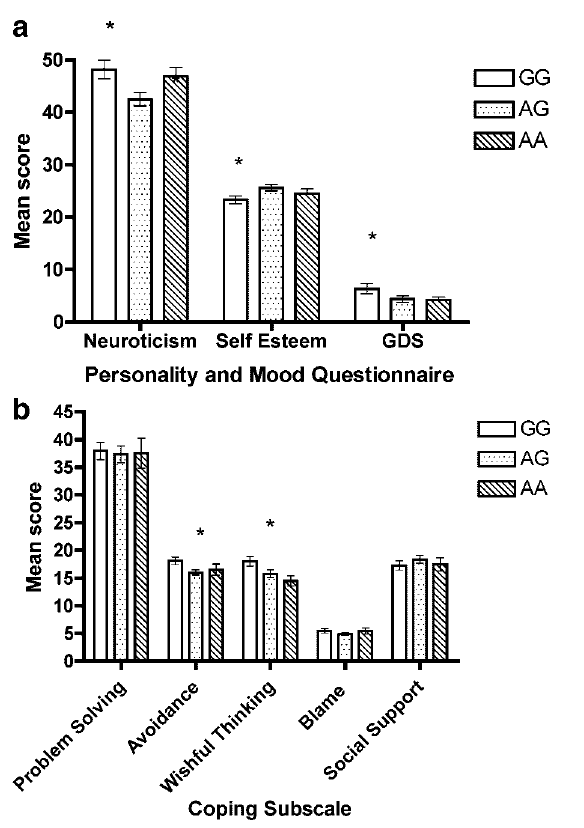
Figure 3. Mean reaction time (SE) on the selective attention task for stimulus absent and stimulus present conditions across genotype group. to the GG or AG group. As the number of distracter stimuli reached a maximum (i.e., 10 distracter stimuli), the AA group displayed the same reaction time as the other groups. No differences were found, however, when target stimulus was absent ( Figure 3